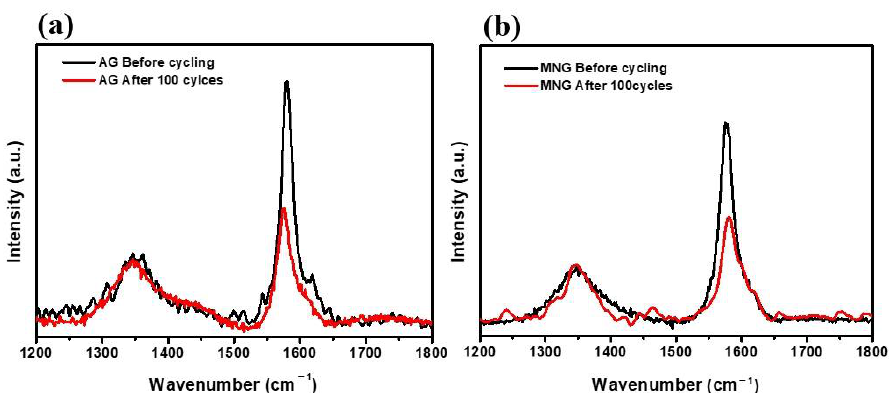
Figure 7. Raman spectra of AG ( a ) and MNG ( b ) electrodes before cycling and after 100 cycles.